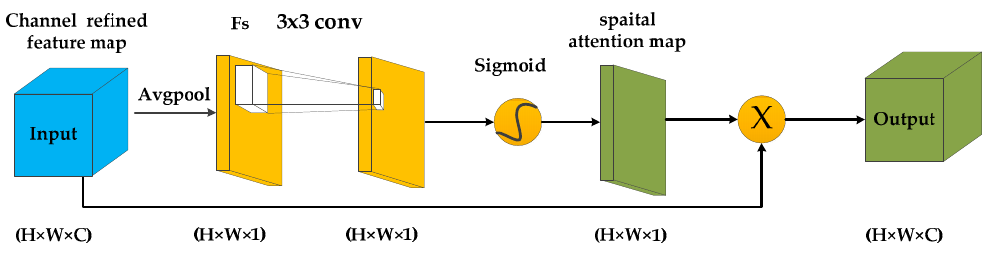
Figure 5. Diagram of spatial attention module.